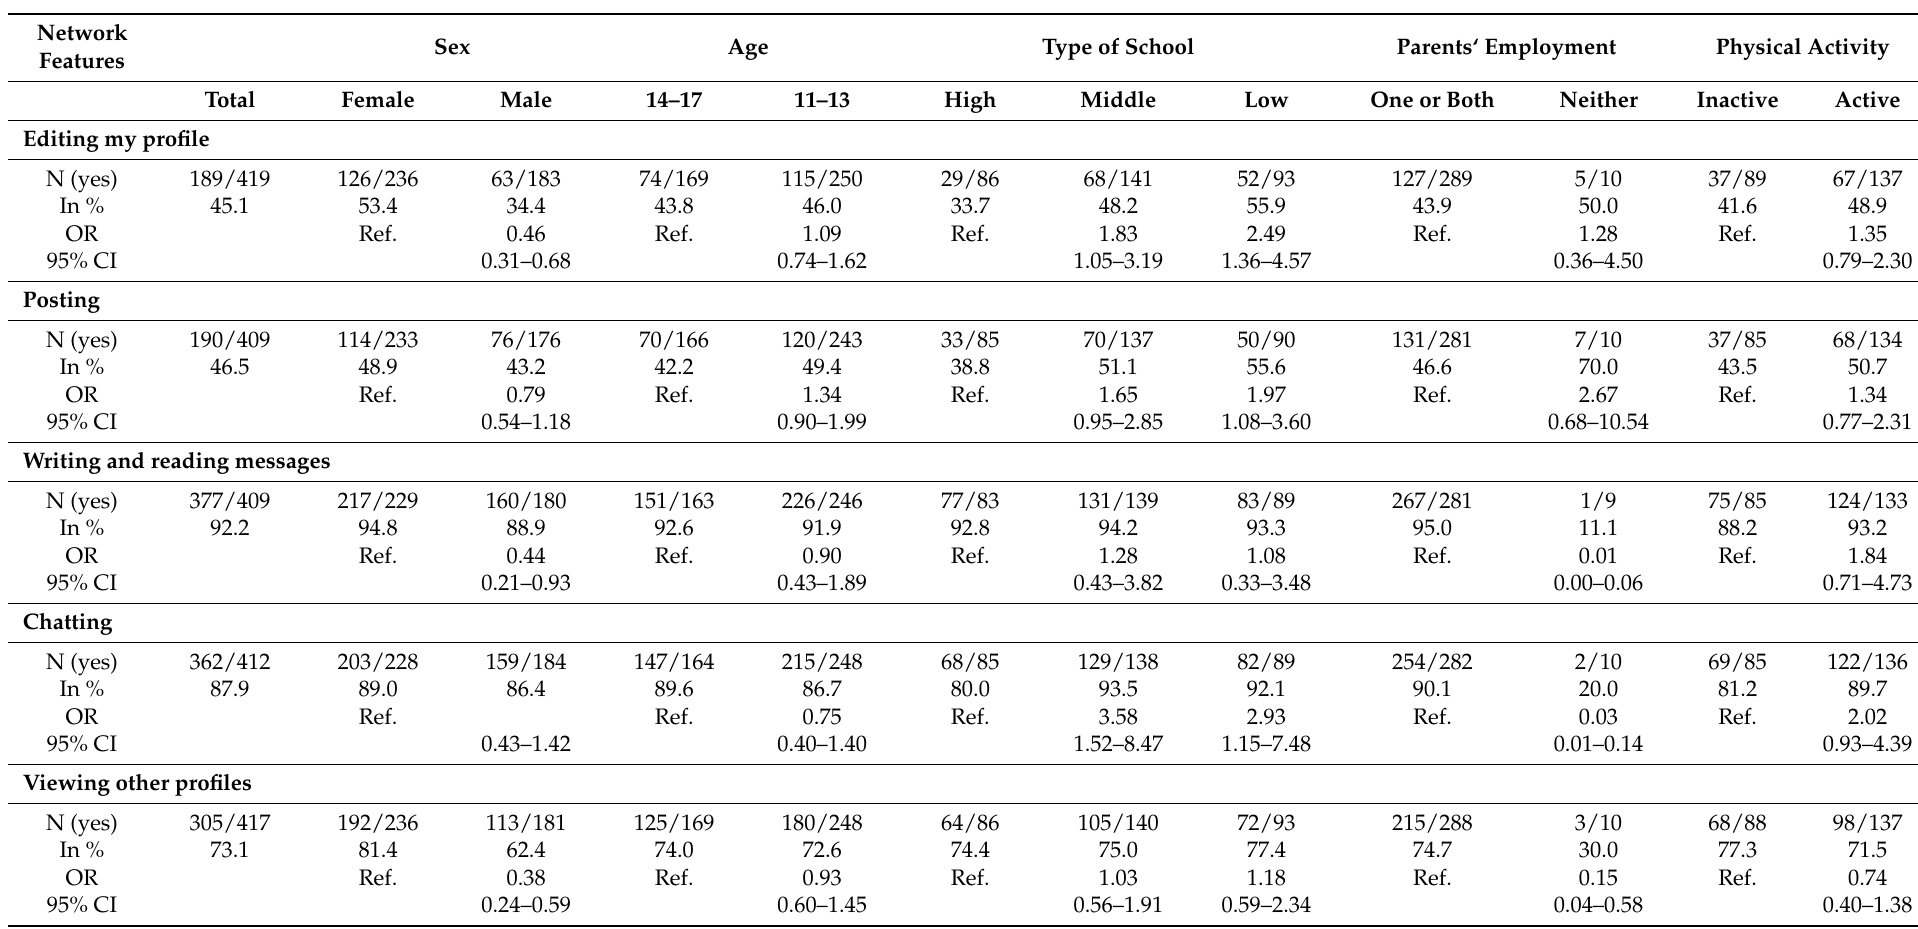
Table 3. Indicators and statistics on social network use by sociodemographic